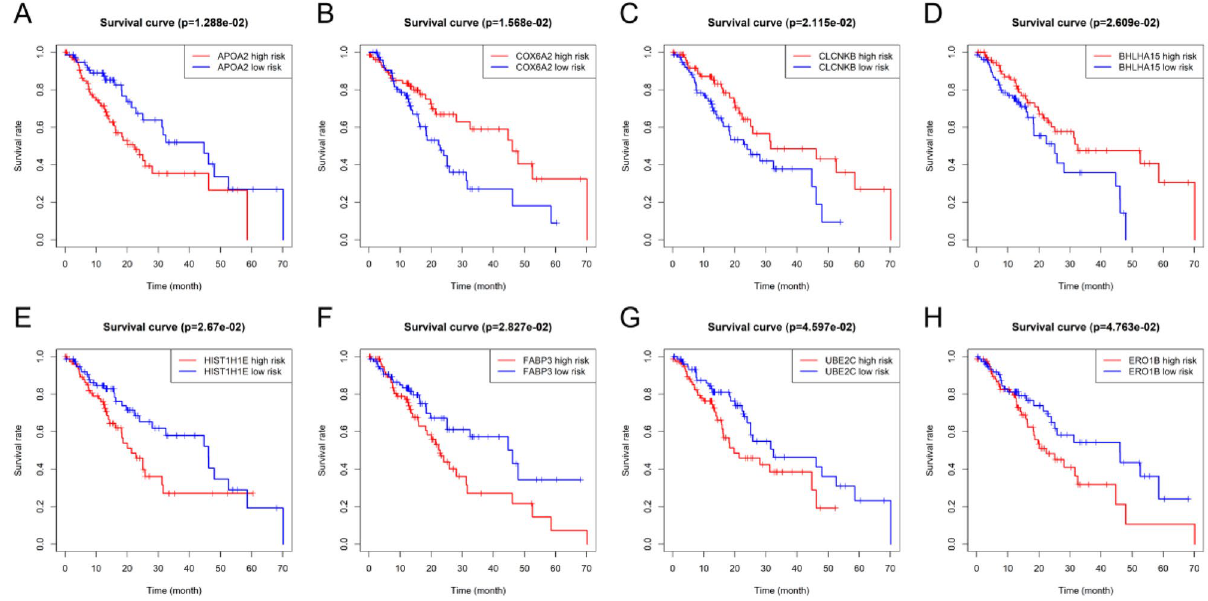
Figure 6. Kaplan–Meier (KM) survival curves of the EC patients with low or high individual risk score of eight genes. ( A ) Survival curve of APOA2. ( B ) Survival curve of COX6A2. ( C ) Survival curve of CLCNKB. ( D ) Survival curve of BHLHA15. ( E ) Survival curve of HIST1H1E. ( F ) Survival curve of FABP3. ( G ) Survival curve of UBE2C. ( H ) Survival curve of ERO1B. The red line represents the high-risk group and the blue line represents the low-risk